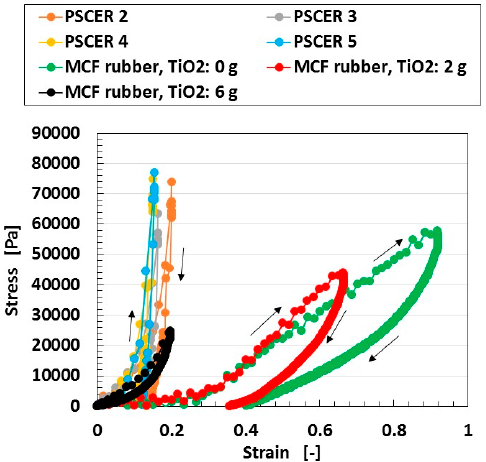
Figure 7. Relation between strain and stress of MCF rubber and PSCERs without dye and electrolyte by tensile testing machine. Wet-type MCF rubber solar cell with TiO 2 was electrolytically polymerized under a magnetic field. Arrows indicate the progress from tension to its removal.